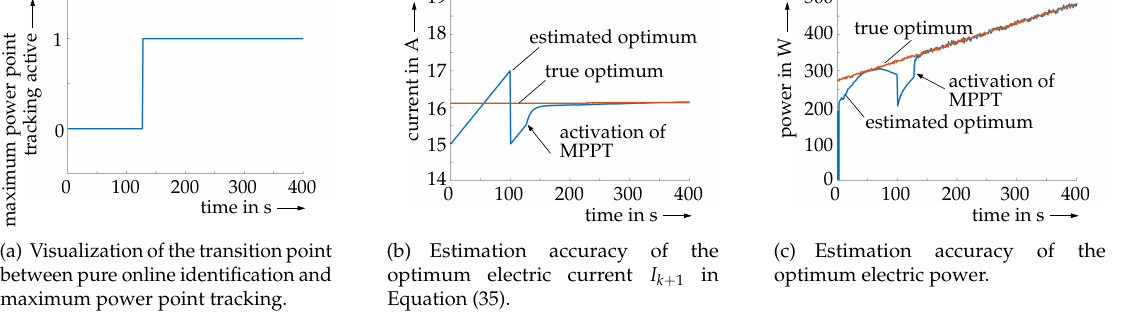
(c) Estimation accuracy of the optimum electric power.